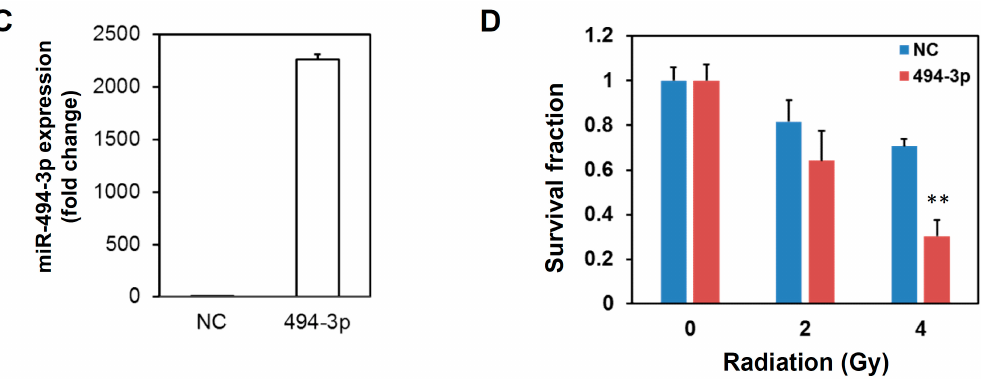
Figure 1. miR-494-3p regulates radiosensitivity of SAS oral squamous cell carcinoma (OSCC) cells. ( A ) SAS cells were irradiated as 2 or 4 Gy and cultured for further 72 h. Cell viability was determined by WST-1 reagent and miR-494-3p expression was measured by qRT-PCR; ( B ) SAS cells were transfected with 100 nM miR-494-3p inhibitor (494-3p inhibitor) or negative control inhibitor (Ctrl inhibitor) for 48 h. Cells were irradiated as 2, 4, or 8 Gy and cultured for further 72 h followed by determination of cell viability with WST-1. Data were presented as survival fraction as comparison with non-irradiated cells. *, p < 0.05; ( C , D ) SAS cells were transfected with 100 nM miR-494-3p mimic (494-3p) or negative control mimic (NC) for 48 h. The expression of miR-494-3p was determined by qPCR ( C ). Transfected SAS cells were irradiated as 2 or 4 Gy and cultured for further 72 h. Cell viability was determined by WST-1 reagent. Data were presented as survival fraction as comparison with non-irradiated cells ( D ). **, p < 0.01.